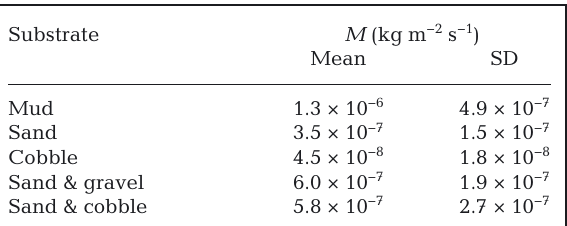
Table 1. Erodibility parameter ( M) values for erosion of salmon fecal waste material on the 5 different bottom sub- strates in the Gust erosion chamber experiments (n = 6 per substrate). Critical shear stress ( τ crit ) = 0.01 Pa in all experi- ments; with τ crit being the shear stress required for incipient motion of fecal waste material